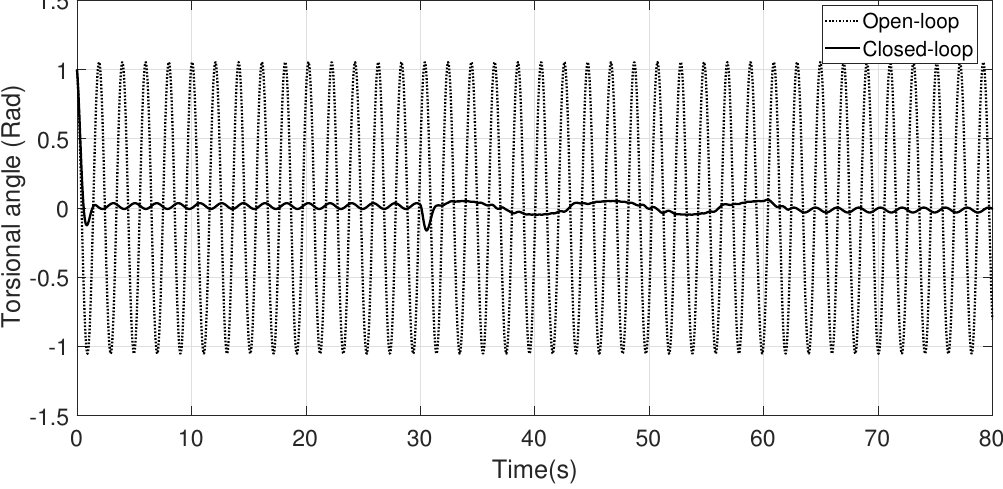
Figure 3. Numerical experiments: Torsional angle